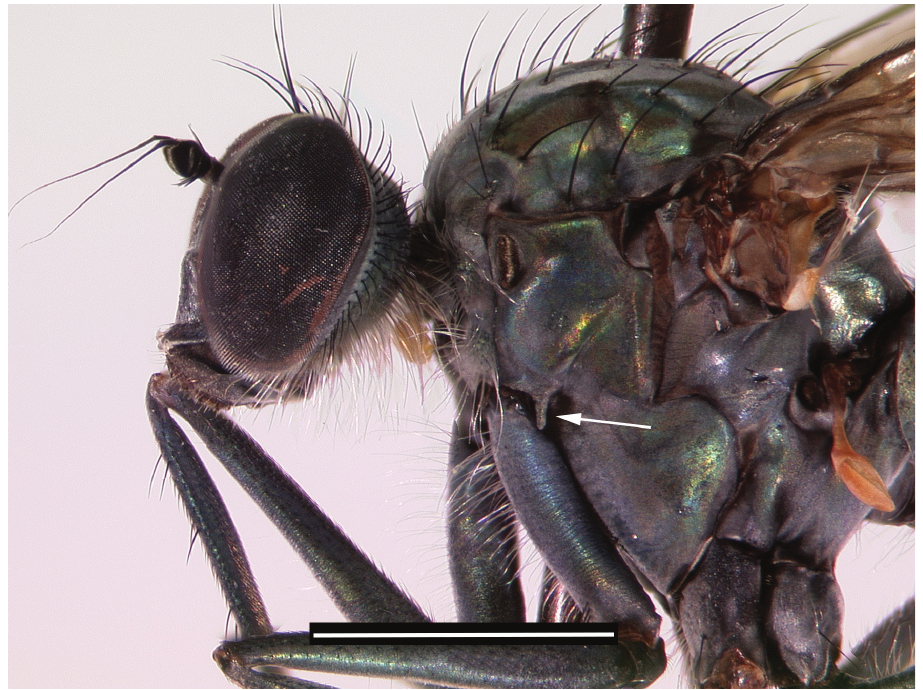
Figure 1. Lateral view of head and thorax of the holotype of Liancalus pterodactyl sp. n. The finger-like projection on the proepimeron is indicated with an arrow; this lobe is diagnostic for the genus Liancalus . Scale bar = 1